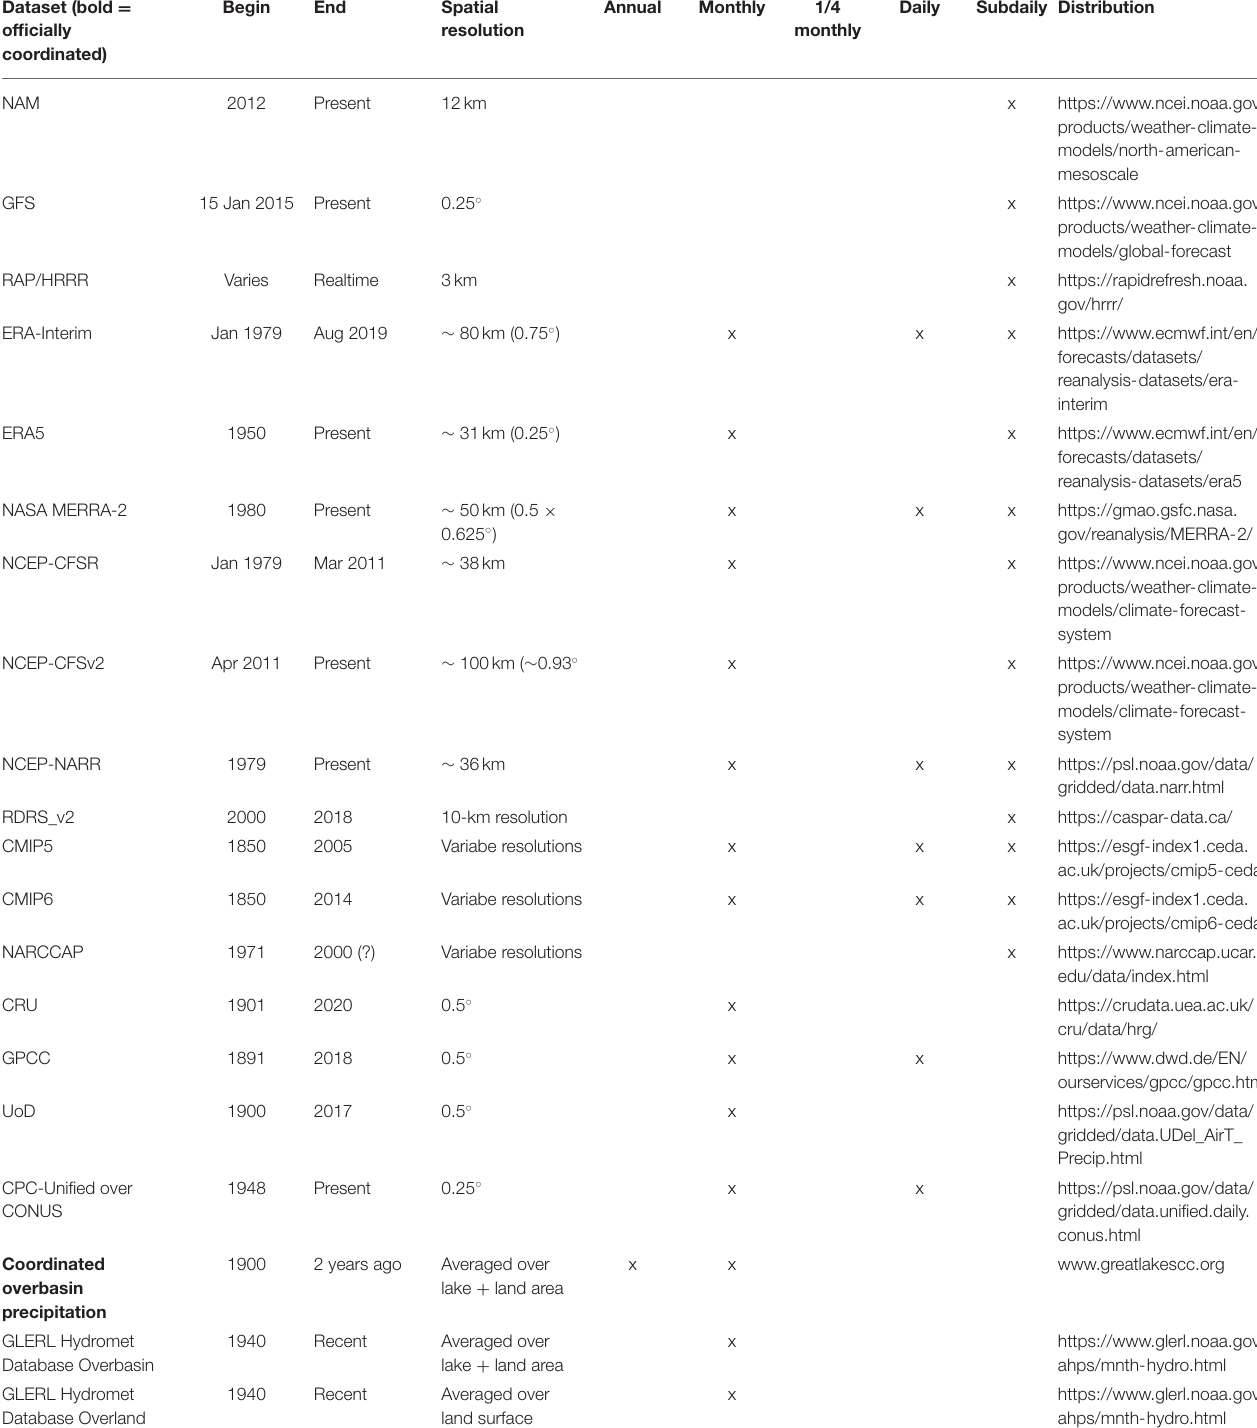
TABLE 5 | Meteorological forcing data products. Dataset (bold =